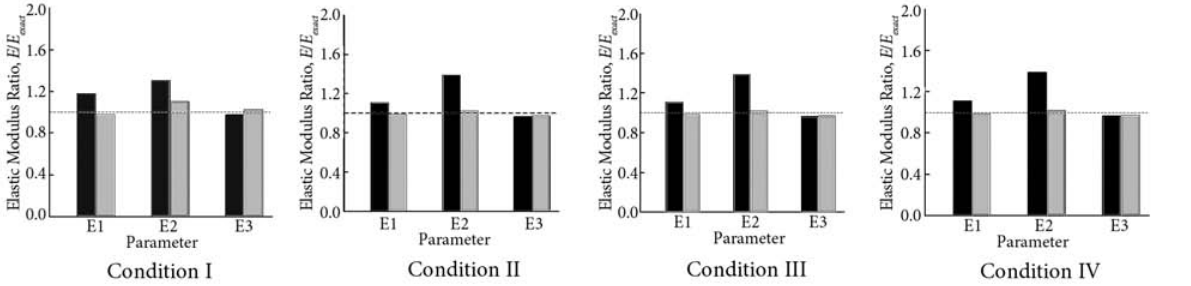
Fig. 8. Inverse analysis results for conditions with modeling errors of 5% for half space boundary case: – conventional NN;